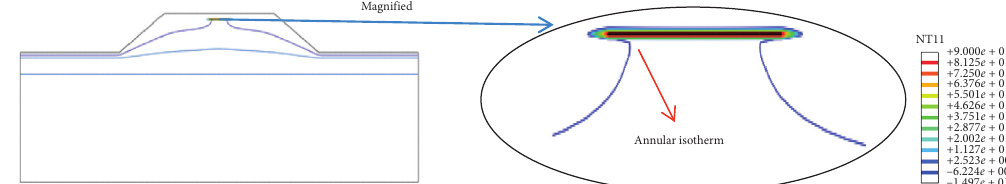
Figure 12: Temperature field distribution characteristics of the polymer grouting material at the maximum central temperature.